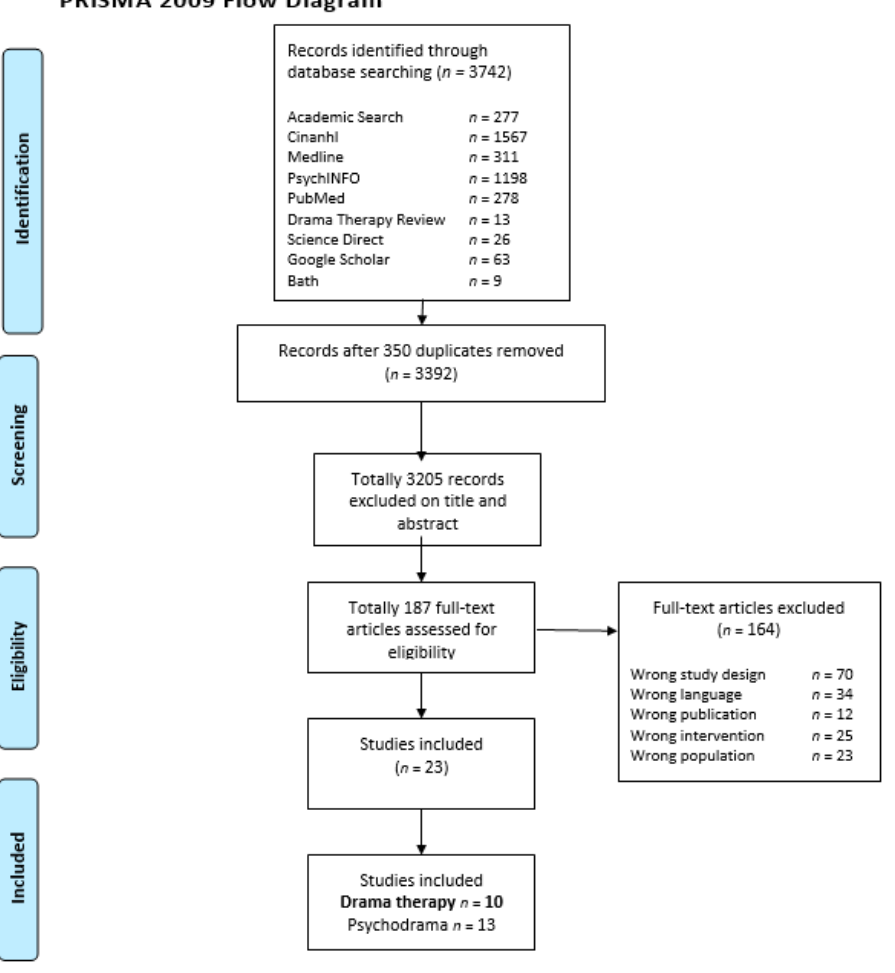
Figure 2. Flow chart of the search results.